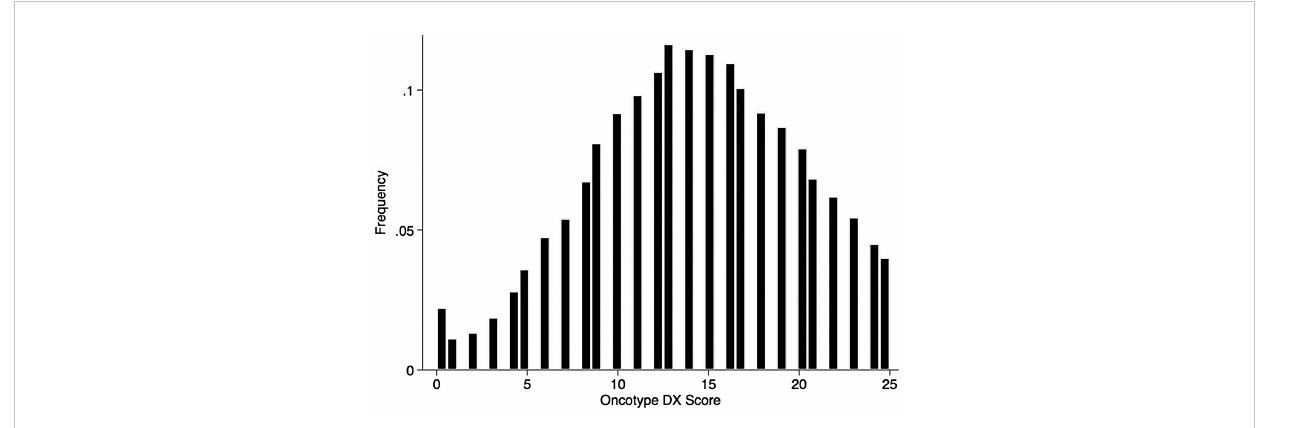
FIGURE 2 Histogram of RS among the pathological stage I-III HR+HER2- breast cancer patients with 1 – 3 positive nodes, data shown as percent of